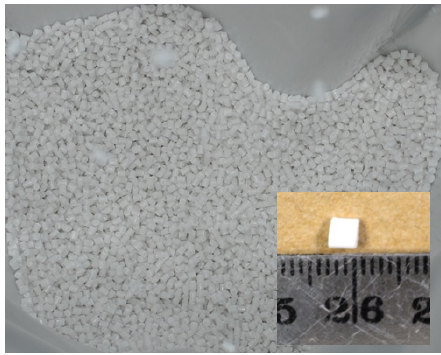
Appl. Sci. 2018, 8, x FOR PEER REVIEW